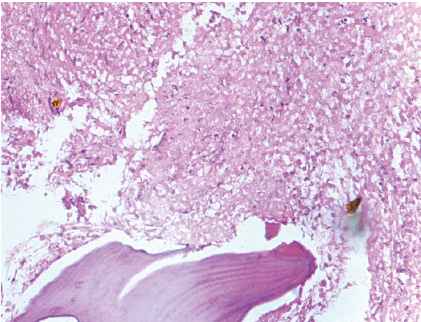
Figure 2: Post therapy histological section of bone marrow biopsy showing marked hypocellularity (400x magnification).